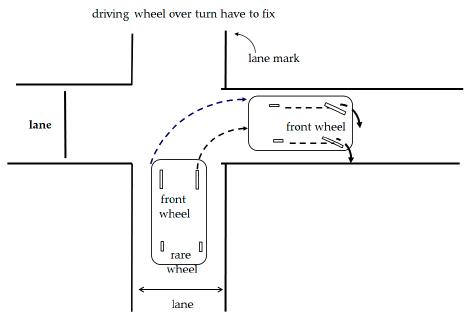
Figure 8. Over-turned front